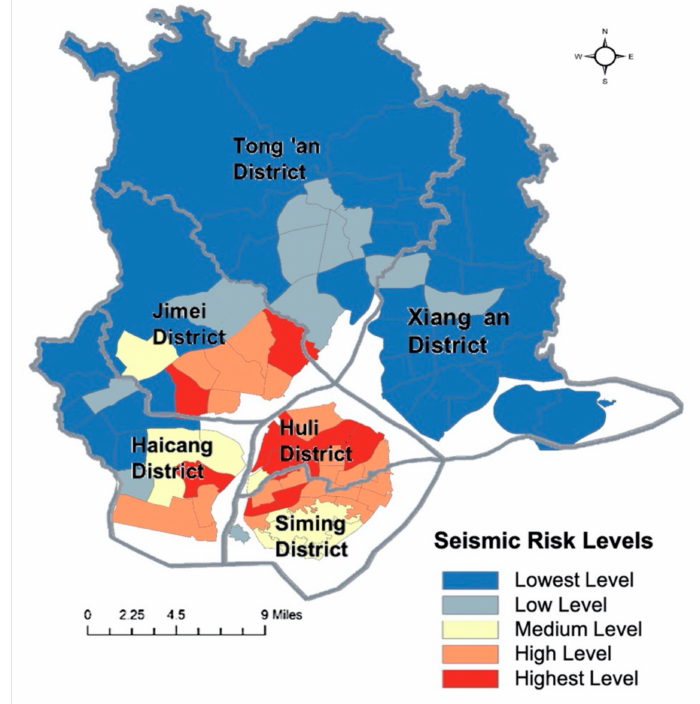
Figure 6. The overall seismic risk distribution of